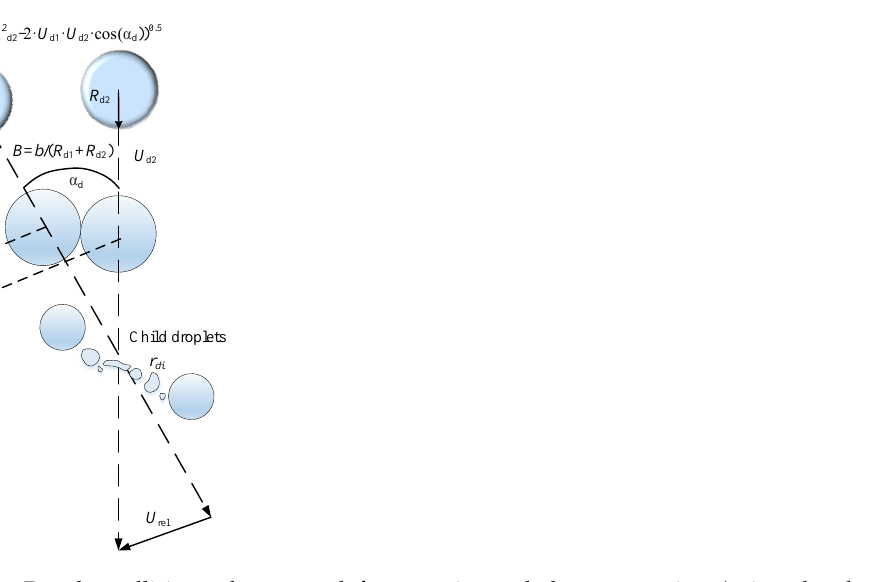
Figure 3. Droplet collision scheme used for experimental data processing (using the data from [12,24]).